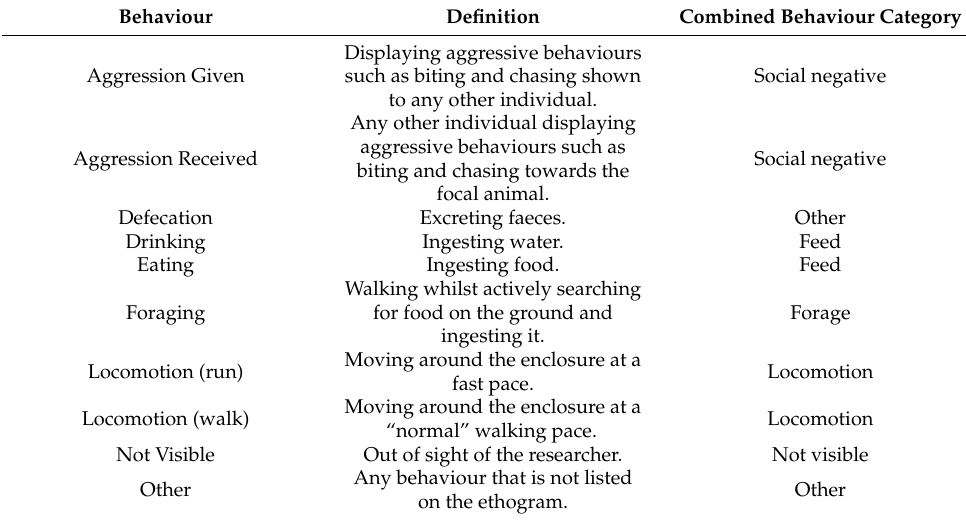
Table A4. Malayan tapir ( Tapirus indicus ) sub-project